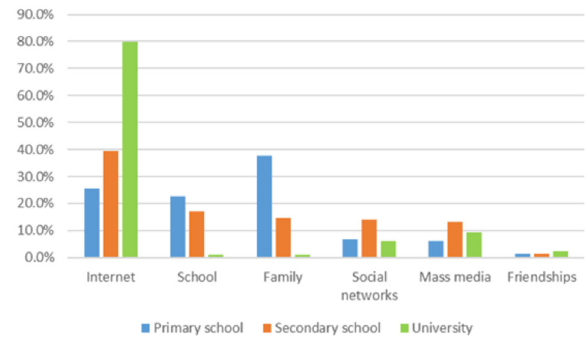
Fig. 2 Student preferred sources of news to stay updated on climate change. The bars represent the percentage. The bars represent the percentage in each